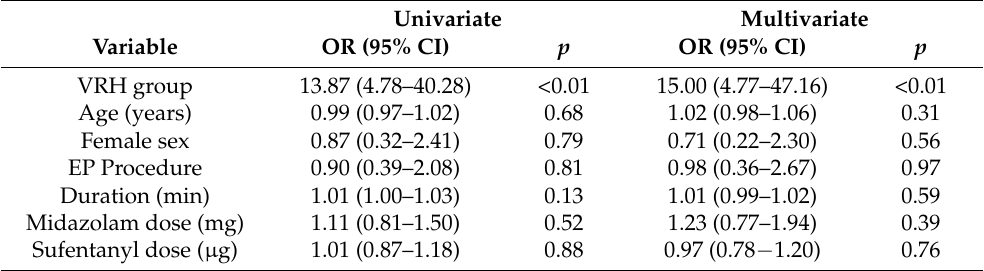
Table 5. Univariate and multivariate analysis results for VRH use regarding the comfort of the procedure assessed with a postoperative visual analogue scale (VAS). VRH: virtual reality hypnosis; EP procedure: electrophysiological procedure; OR: odds ratio; CI: confidence